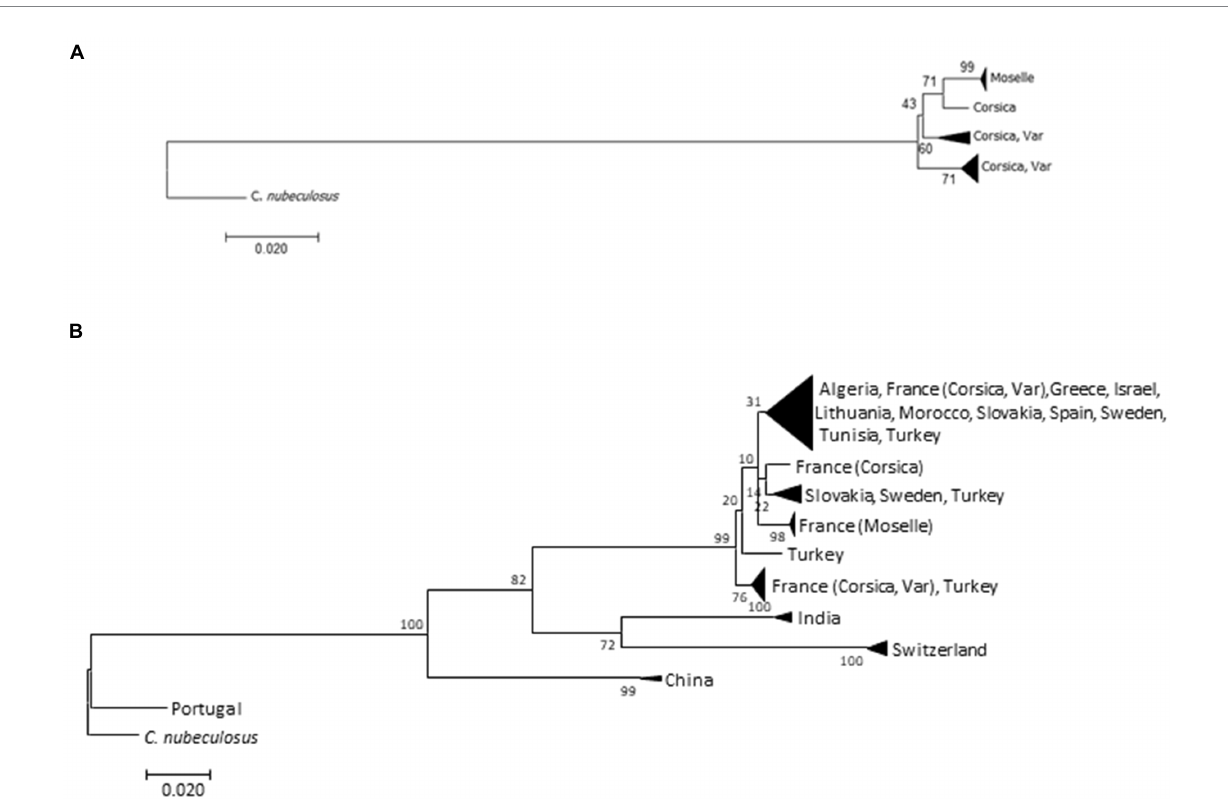
FIGURE 3 Trees obtained from the analysis of Culicoides circumscriptus cytochrome oxides I (COI) mitochondrial DNA using the neighbor-joining method (A) on our samples and the maximum-likelihood method (B) on both GenBank sequences and our data. Bootstrap values are shown on nodes (1,000